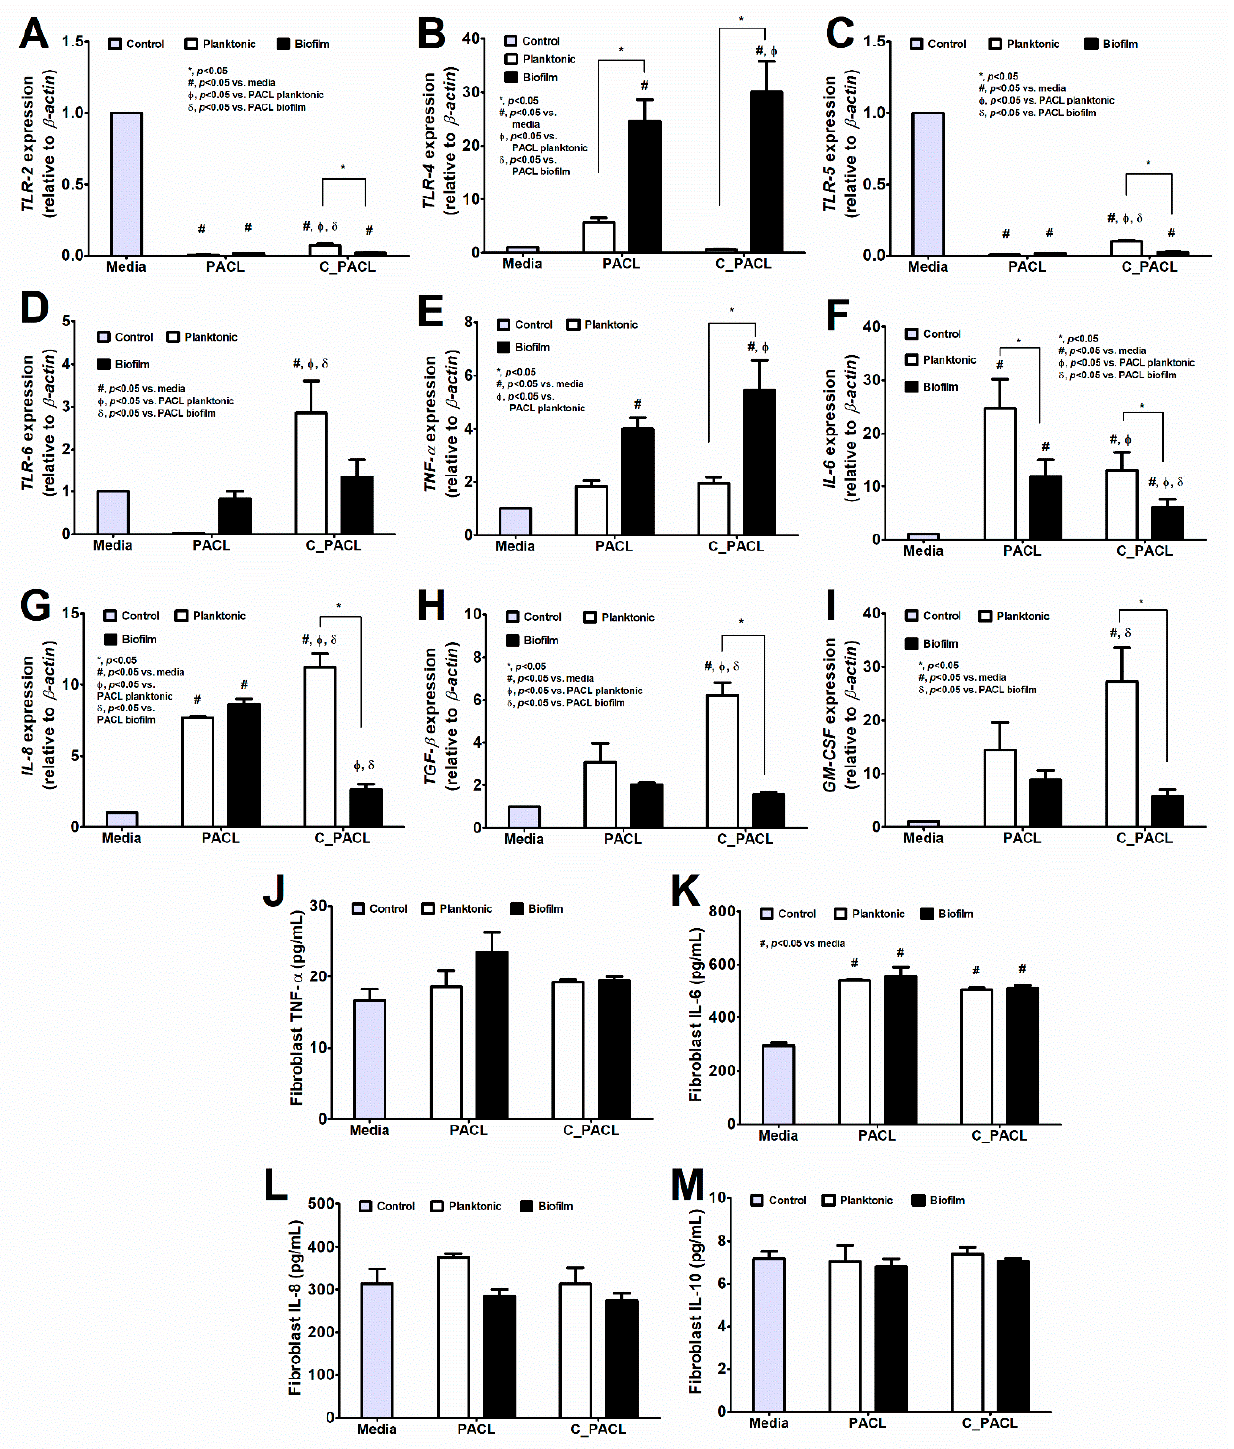
Figure 8. The responses of fibroblast toward P. aeruginosa parent strain (PACL) and Chlorhexidine (CHG)-treated strain (C_PACL) in planktonic (non-biofilms) and sessile (biofilms) forms. The gene expressions by qRT-PCR of TLR-2 , TLR-4 , TLR-5, and TLR-6 ( A – D ) and pro-inflammatory cytokines ( TNF- α , IL-6 , IL-8 , TGF- β , and GM-CSF ( E – I ) with supernatant cytokines using ELISA ( TNF- α , IL-6 , IL-8 , and IL-10 ) ( J – M ) are demonstrated. The experiments were performed in independent triplicate. Mean ± SEM are presented with the one-way ANOVA followed by Tukey’s analysis (*, p ˂ 0.05; # , p < 0.05; Φ , p < 0.05; and δ , p < 0.05 considered statistically significant).